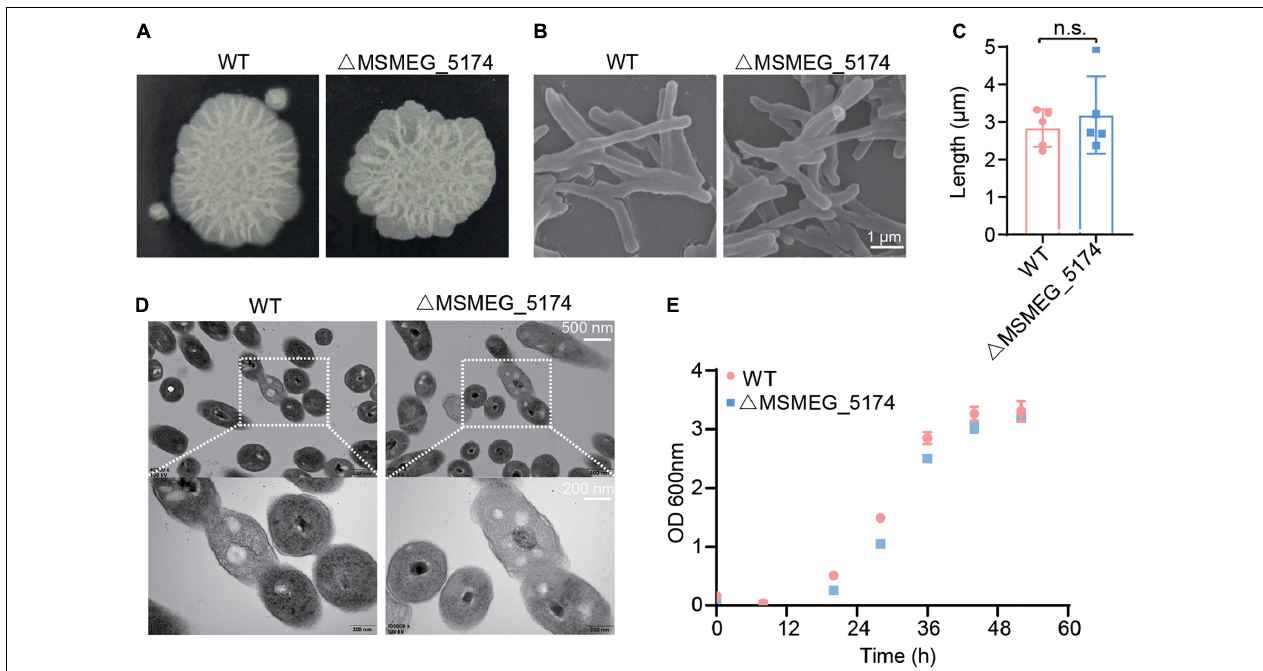
FIGURE 1 | The effect of MSMEG_5174 deficiency on the basic characteristics of Mycobacterium smegmatis . (A) The morphology of WT and MSMEG_5174 mutants grown in 7H9 agar. (B) Scanning electron microscopic micrographs of WT and MSMEG_5174 mutants. (C) The length of WT and MSMEG_5174 mutants, each point represents a single cell from a field of view. (D) Transmission electron microscopic micrographs of WT and MSMEG_5174 mutants. (E) The growth of WT and MSMEG_5174